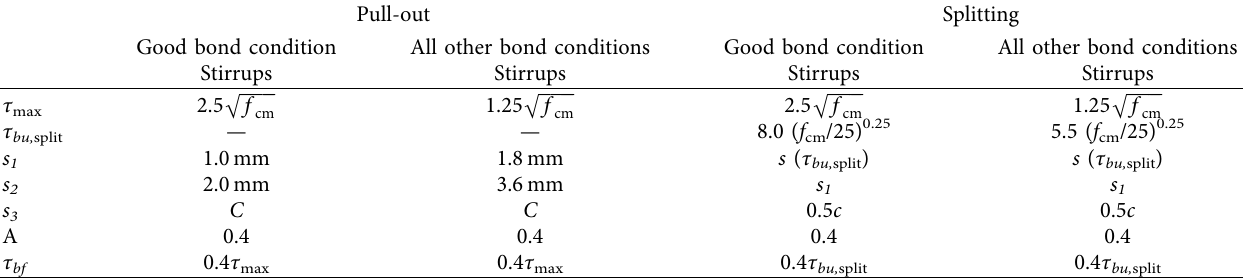
Table 2: Values of parameters in the bond-slip